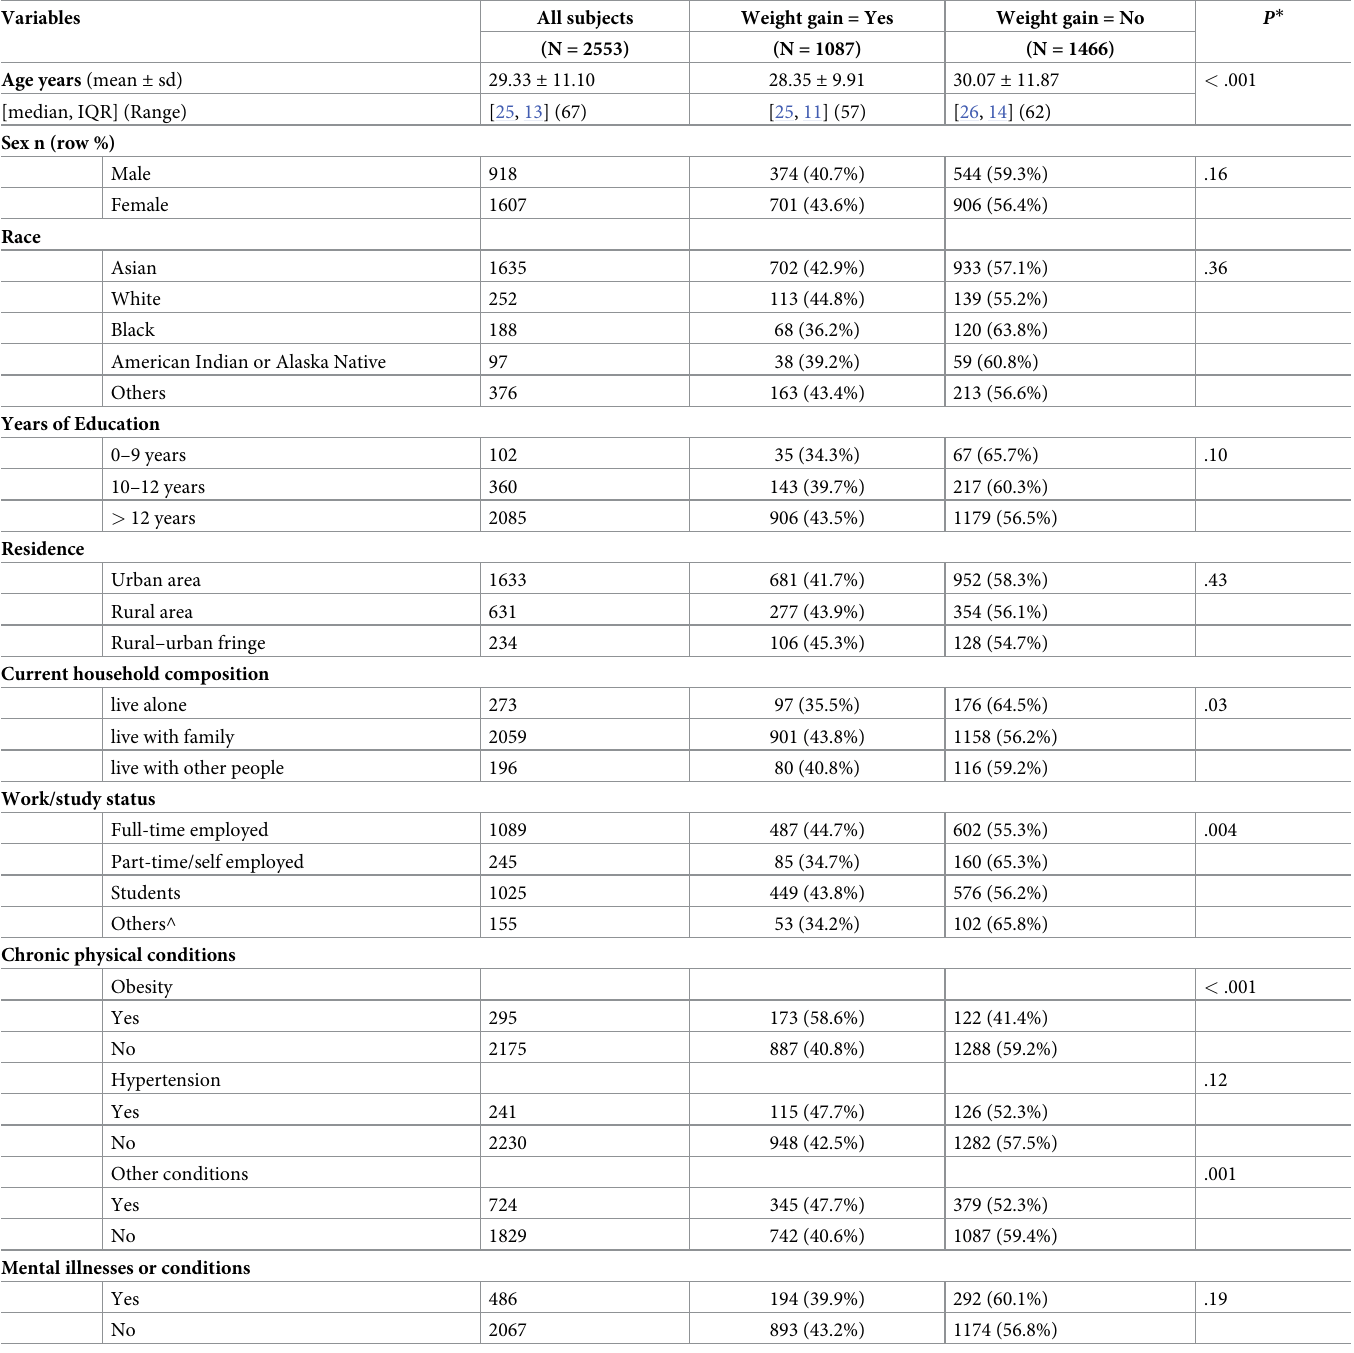
Table 1. Characteristics of the